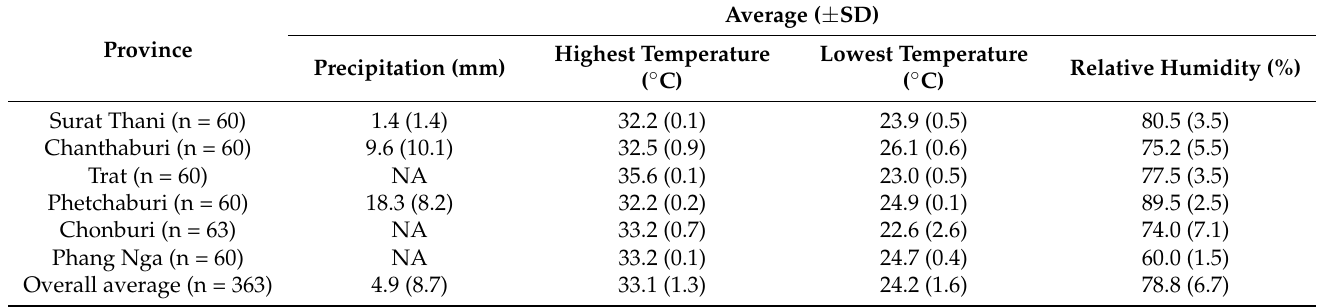
Table 2. Average and SD of daily weather data retrieved from the Meteorological Department from